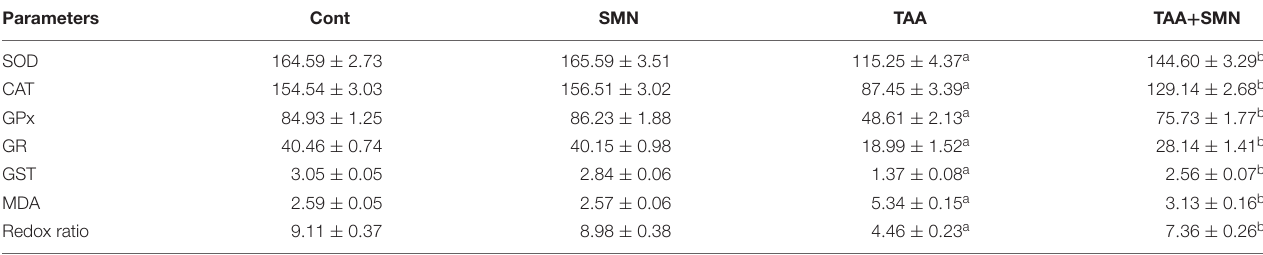
TABLE 3 | Effect of TAA and SMN on antioxidant enzymes activities in liver tissue.